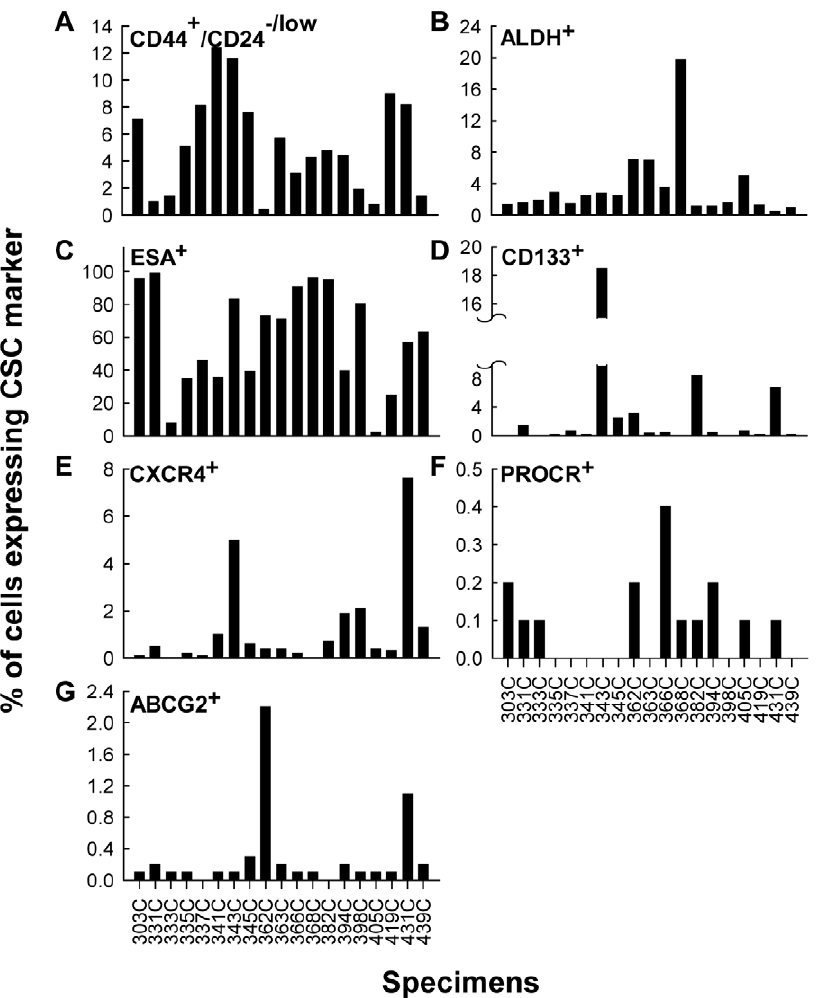
Figure 5. Stem cell marker profiling of primary human breast cancer specimens. Known breast cancer stem cell markers CD44 + /CD24 2 /low (A), ALDH (B) and ESA (C), and other solid cancer stem cell markers CD133 (D), CXCR4 (E), PROCR (F) and ABCG2 (G) were detected in primary human breast cancer specimens using flow cytometry after cell labeling. Each panel shows the percentage of cells from each primary human specimen expressing the indicated stem cell marker. Results are from one experiment since the limited material allowed only one analysis. doi:10.1371/journal.pone.0008377.g005 PLoS ONE |